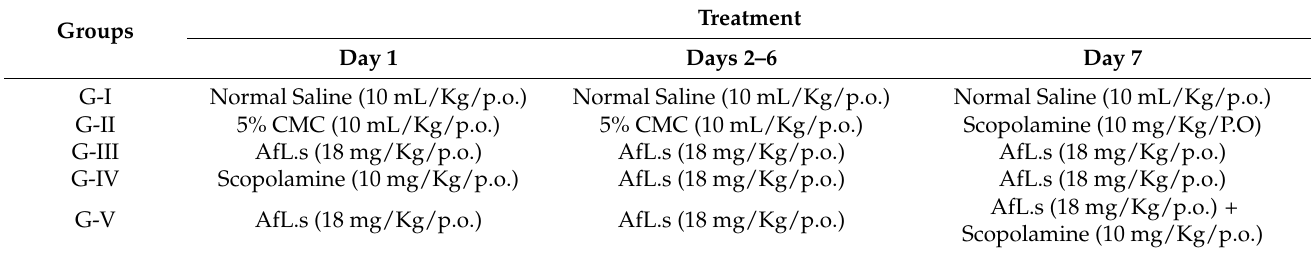
Table 2. Study design for the assessment of choline acetyltransferase (ChAT) activity. Treatment Groups Day 1 Days 2–6 Day 7 G-I Normal Saline (10 mL/Kg/p.o.) Normal Saline (10 mL/Kg/p.o.) Normal Saline (10 mL/Kg/p.o.) G-II 5% CMC (10 mL/Kg/p.o.) Scopolamine (10 mg/Kg/P.O) G-III AfL.s (18 mg/Kg/p.o.) AfL.s (18 mg/Kg/p.o.) AfL.s (18 mg/Kg/p.o.) G-IV Scopolamine (10 mg/Kg/p.o.) AfL.s (18 mg/Kg/p.o.) AfL.s (18 mg/Kg/p.o.) AfL.s (18 mg/Kg/p.o.) + AfL.s (18 mg/Kg/p.o.) AfL.s (18 mg/Kg/p.o.) Scopolamine (10